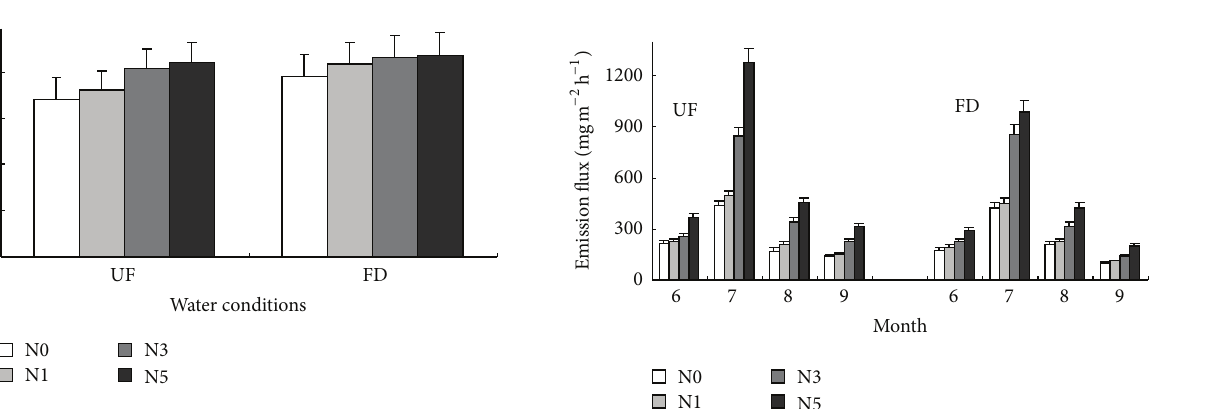
Figure 4: Effects of N-deposition on the wetland soil DOC.